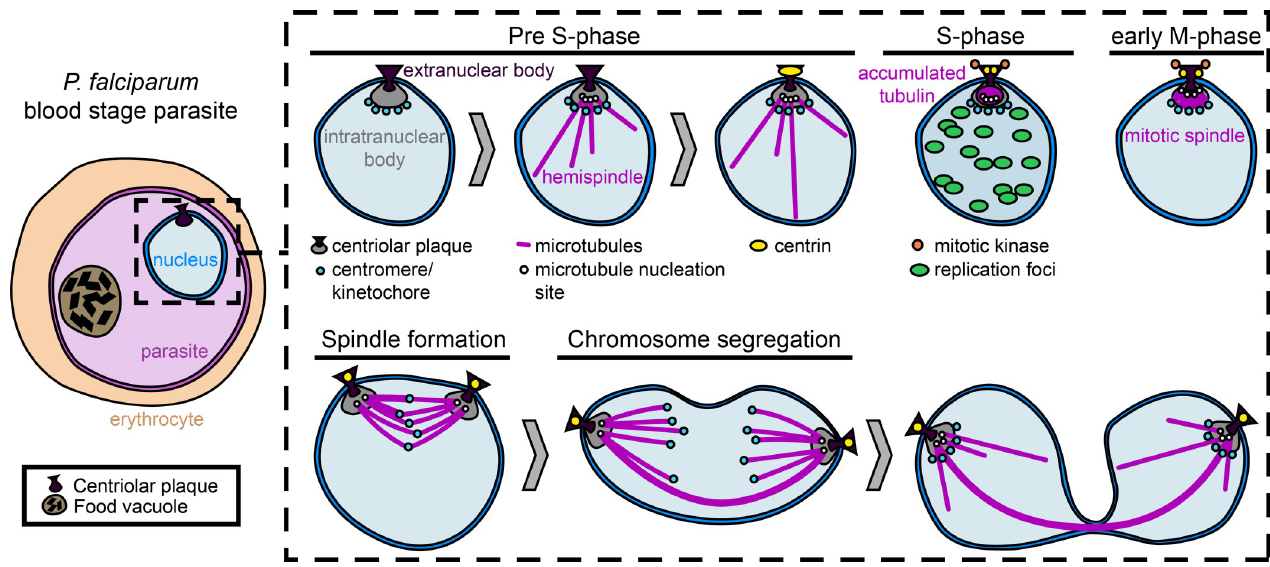
Fig 1. Progression of nuclear cycle stages in mononucleated parasites. Nuclear division is organized around the centriolar plaque, which spans the nuclear envelope and consists of an extranuclear compartment and an intranuclear compartment acting as the microtubule organizing center. Prior to S–phase initiation and the formation of a mitotic spindle, large, dynamic hemispindles can be observed in the nucleus. Centrins are recruited to the extranuclear compartment of the centriolar plaque during the later hemispindle stages before S–phase occurs. Nuclear division is closed, with the duplicated centriolar plaques eventually moving to opposite sides of the dividing nucleus during chromosome segregation, before nuclei are